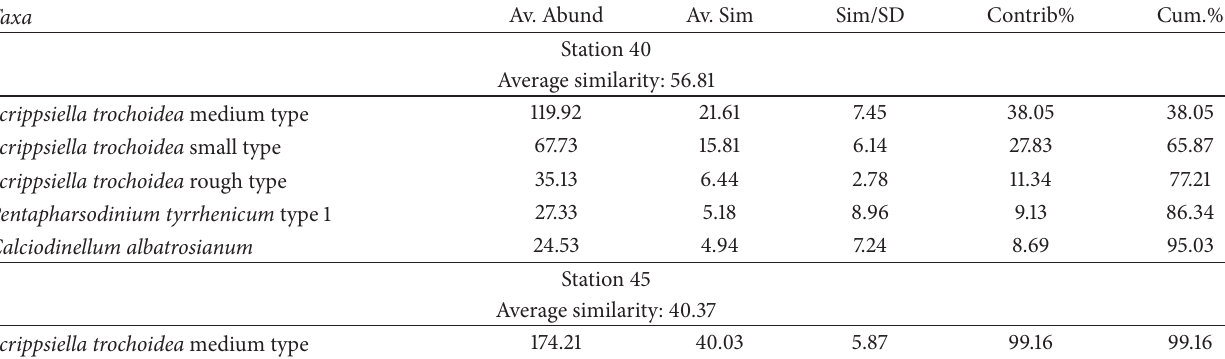
Table 4: Results of SIMPER analysis for resting stages from surface sediments at stations 40 and 45 in Bay of Vlor¨e. Taxa Av. Abund Av. Sim Sim/SD Contrib% Cum.% Station 40 Average similarity: